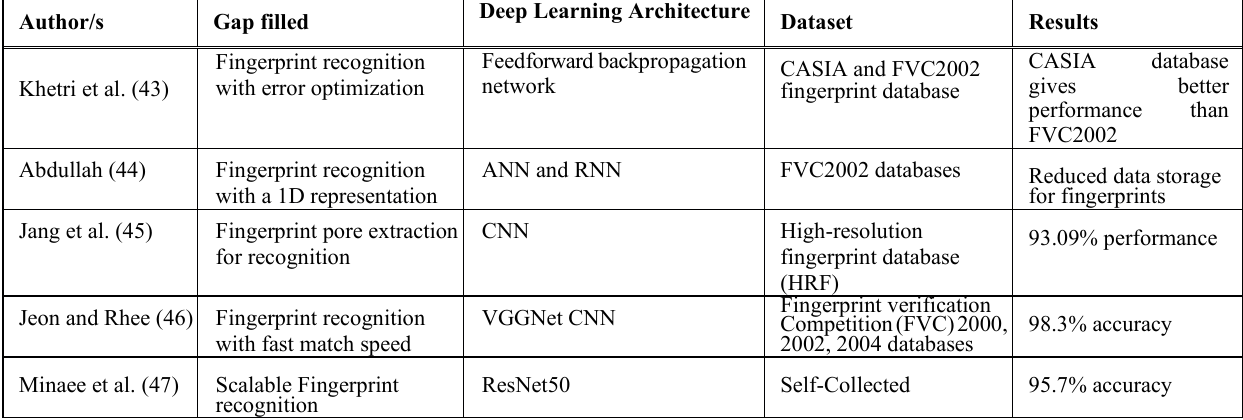
Table 4. Important works on fingerprint-based identification using deep learning.